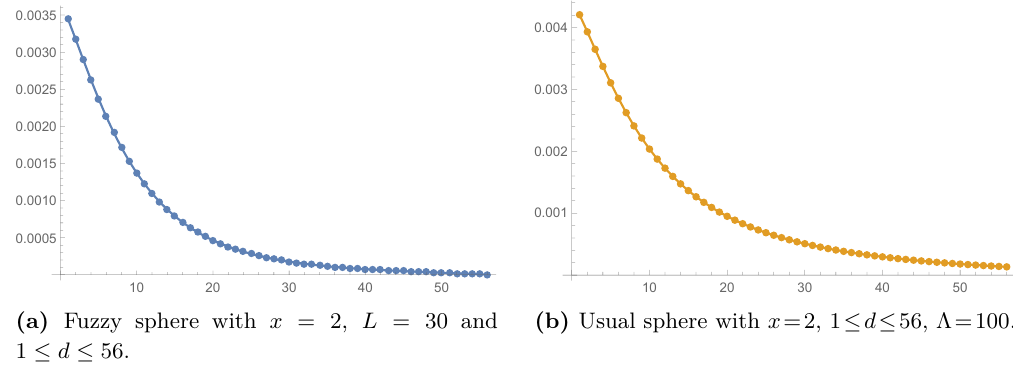
and H ( x,d ) (without − λ 2 ln λ 2 ). The L H 8 R 2